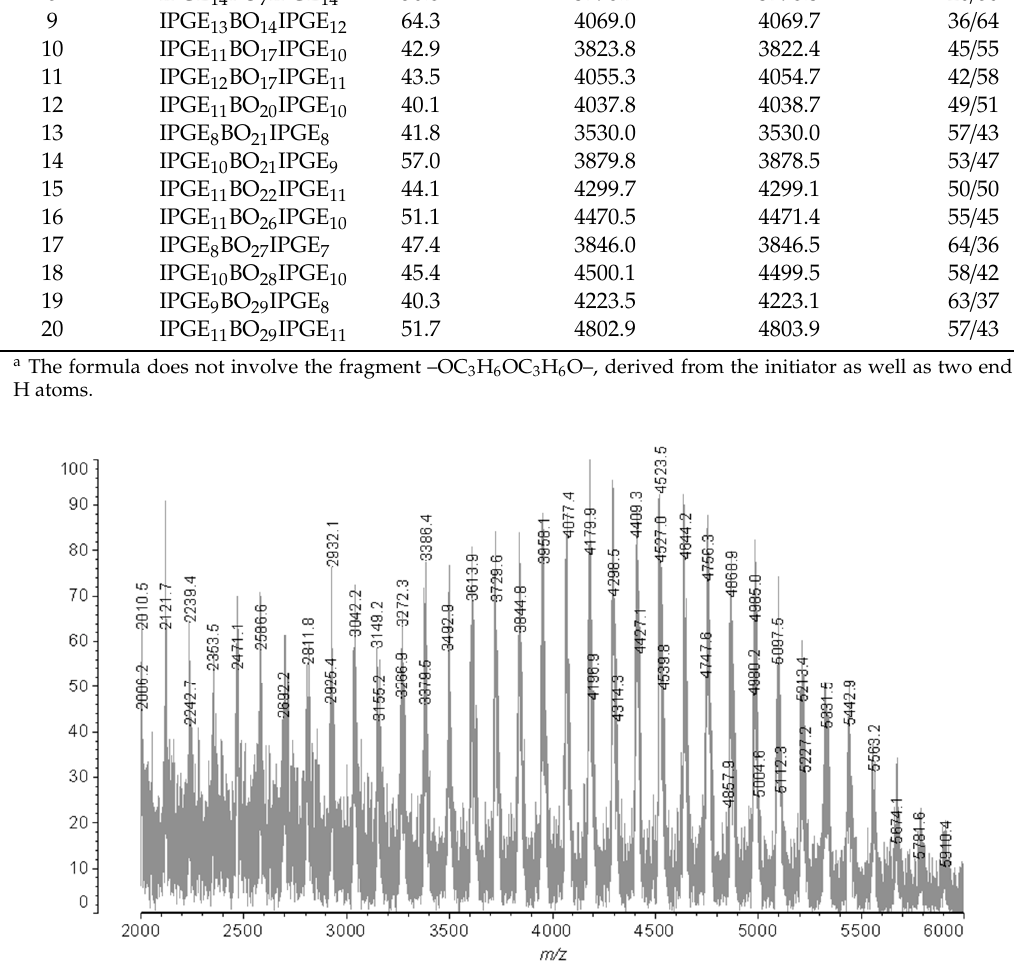
Table 5. Composition of PIPGE/PAGE/PIPGE triblock copolyether-diol (19) determined by MALDI- TOF mass spectrometry.